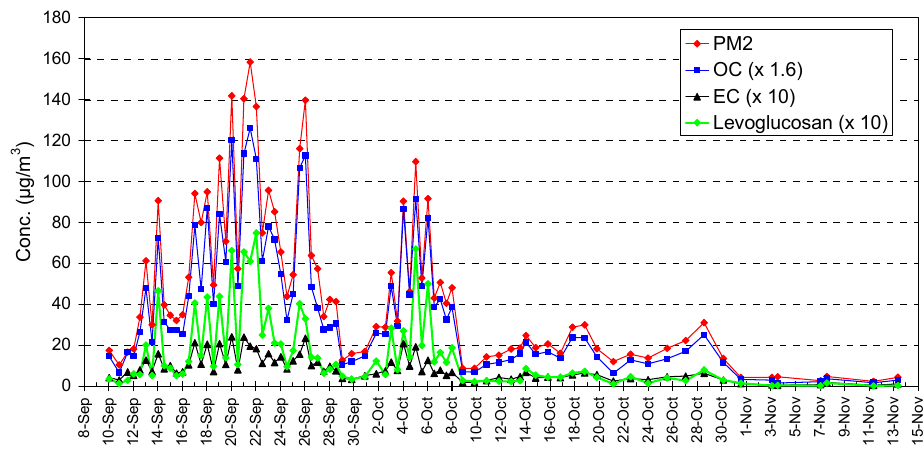
Fig. 2. Time series for fine PM (PM 2 ) , and for OC, EC, and levoglucosan in the fine filters of the HVDS samples.